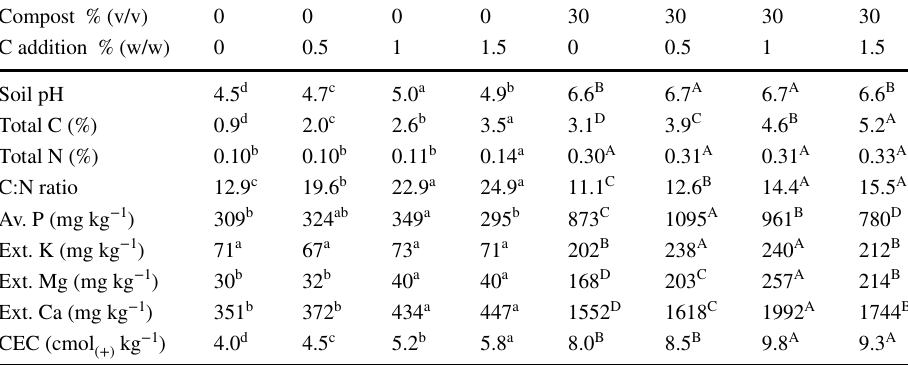
Table 5 Effects of biochar rates (0, 0.5, 1 and 1.5% w/w C addition) on chemical properties of polybag medium without and with compost amendment after 212 days cultivation ( n = 8)